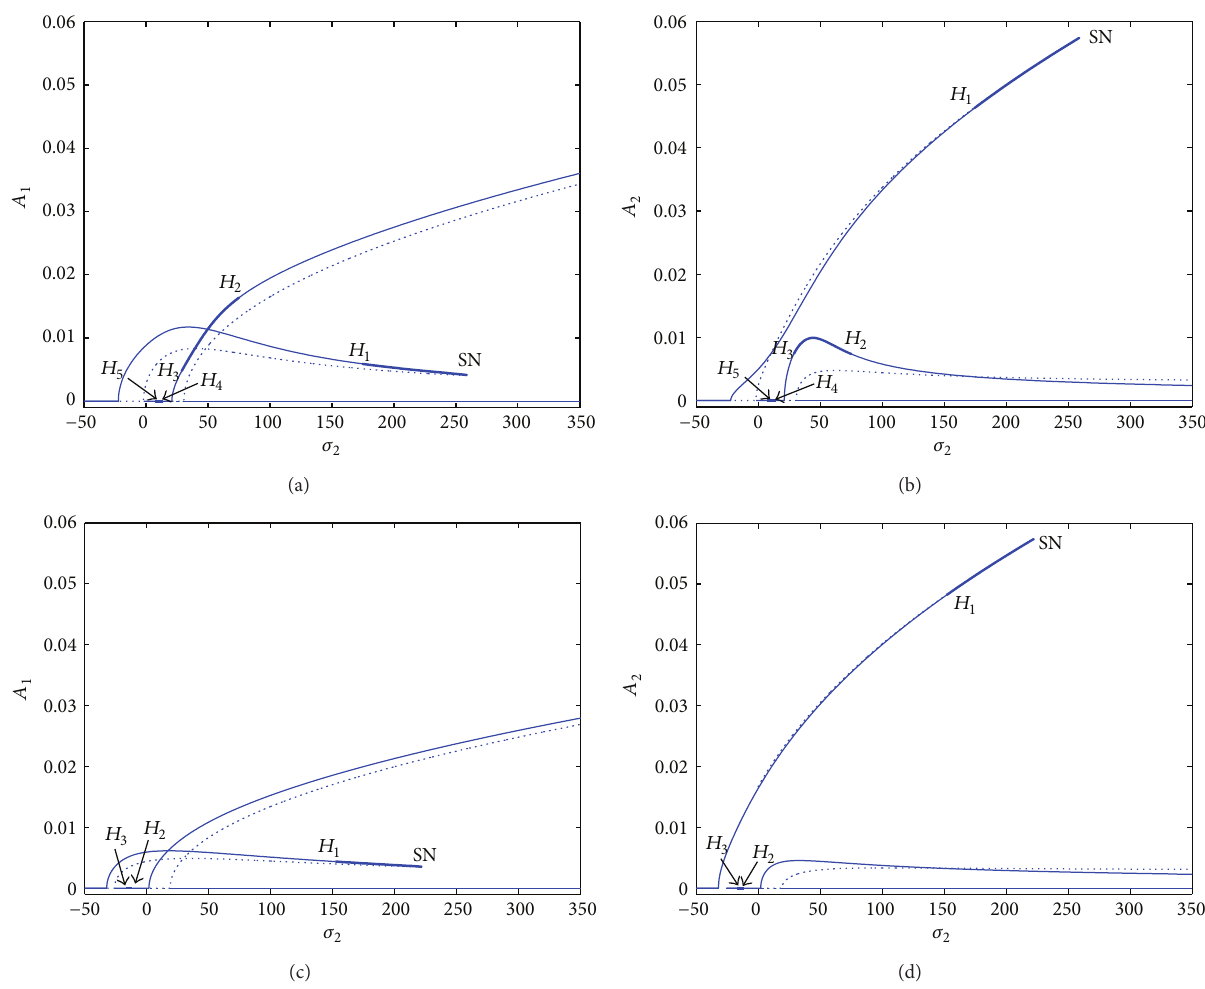
Figure 7: Effect of internal detuning parameter on the frequency response of (a) first mode and (b) second mode for system parameters = 10 , V = 40 , ( a , b ) 𝜎 = 20.320 , and ( c , d )𝜎 𝜇 = 0.1 , 𝛼 = 0 , V 1 𝑙 1